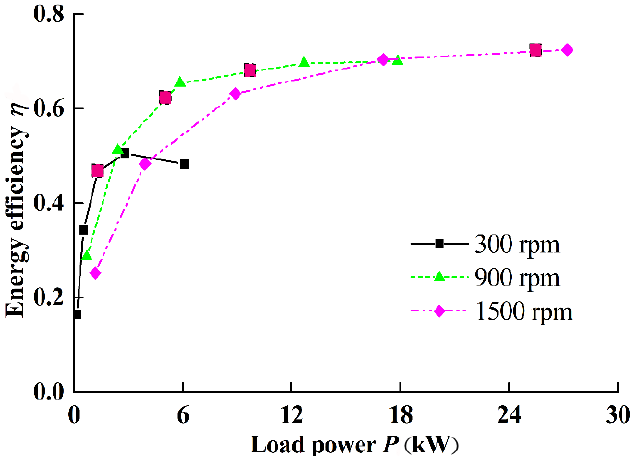
Figure 8. Energy efficiency of a variable-speed and -displacement electro-hydraulic power source.